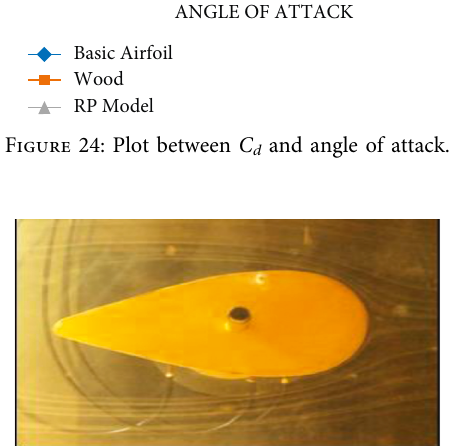
Figure 25: Smoke flow visualization at 0 ° AOA without synthetic jet module.